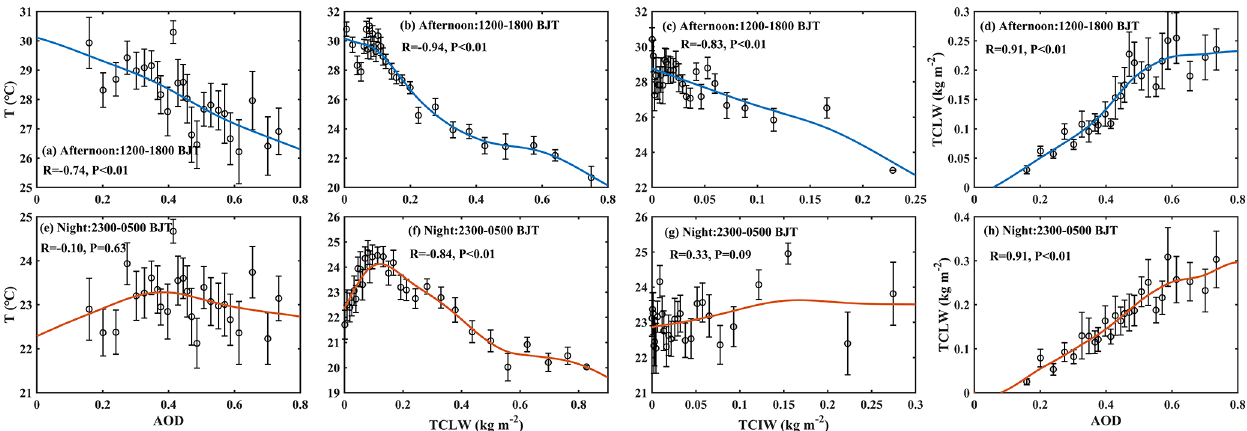
Figure 10. Relationships in (a, e) AOD-T, (b, f) TCLW-T, (c, g) TCIW-T, and (d, h) AOD-TCLW in the afternoon (12:00–18:00BJT) and night (23:00–05:00BJT). Note that samples are first sorted by the variable on the x axis and then samples with similar values of the x variable were averaged to create the presented scatter plot. The max number of samples in each bin is equal to or less than 20. The difference between the maximum and minimum AOD, TCLW, and TCIW values of samples in each bin is equal to or less than 0.05, 0.05, and 0.01. An estimation of the uncertainty was calculated from the standard deviation of each bin divided by the square root of the number of data points in the bin. Smoothing spline-fit curves, Pearson correlation coefficients ( R ), and significant level ( P ) are also shown in each panel.